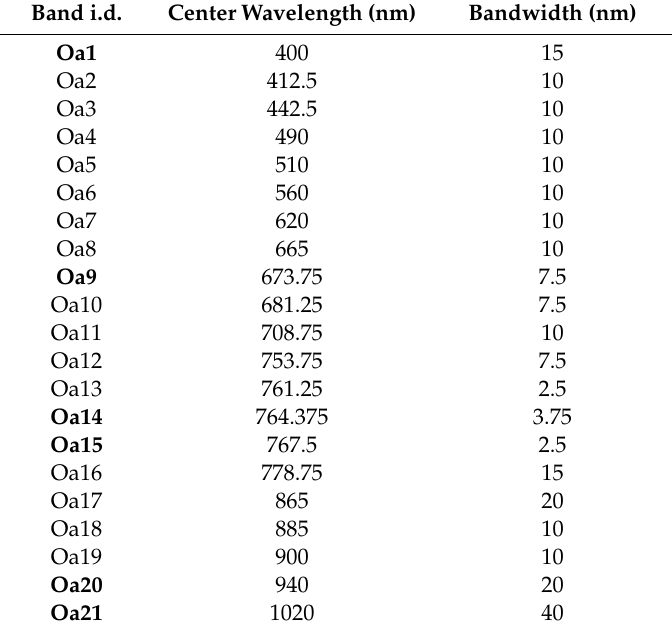
Table 1. OLCI bands with MERIS heritage bands and additional highlighted in bold (source: